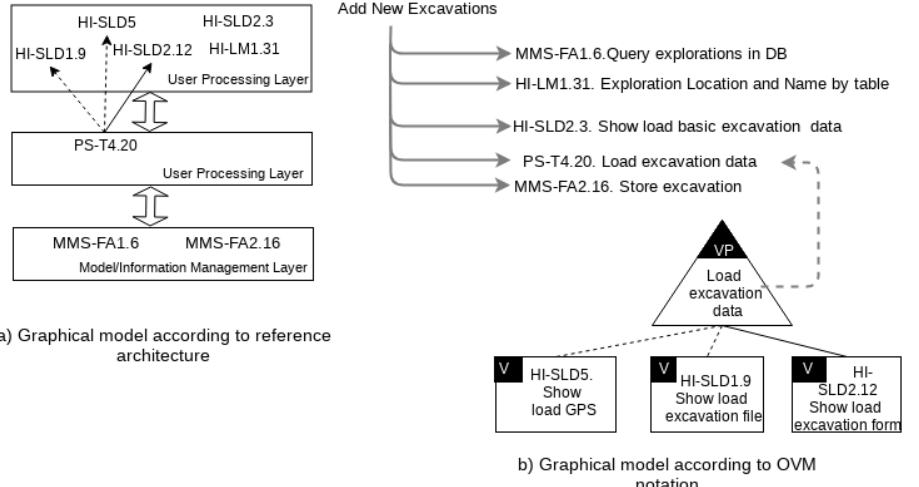
Figure 13. Different diagrams included into the variability model item of the functional datasheet Add New Excavations . ( a ) Model according to reference architecture. ( b ) Model according to OVM